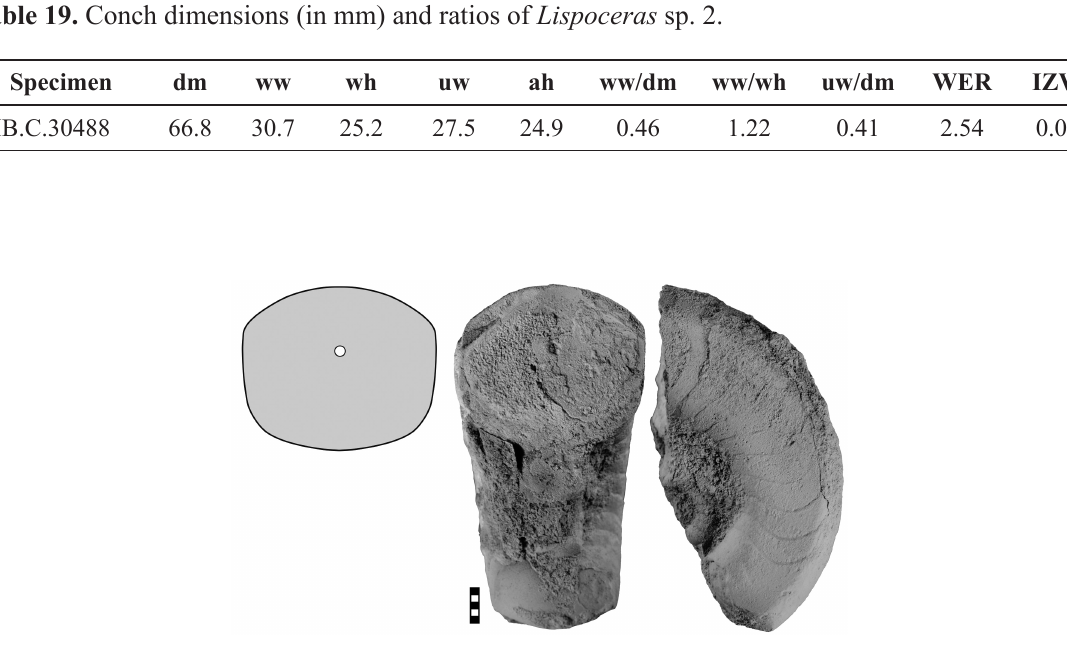
Fig. 31. Lispoceras sp. 2, specimen MB.C.30488 (Wendt and Kaufmann 1995 Coll.) from Azzel Matti; lateral view and whorl profile. Scale bar units = 1 mm.